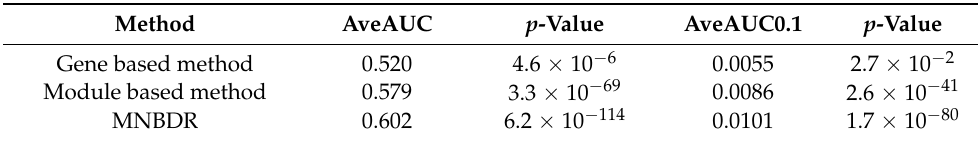
Table 1. The performances of three methods on the 19 cancer